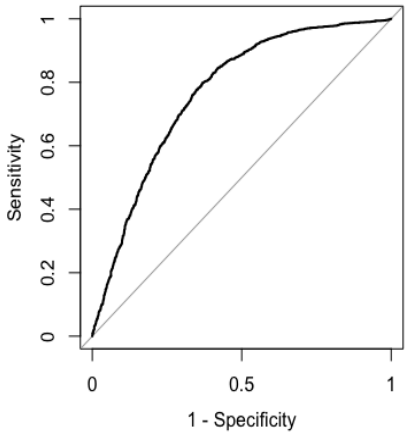
Figure 10. ROC curve for DNN (ReLU w/Dropout). (AUC = 0.765, F-score = 0.735).